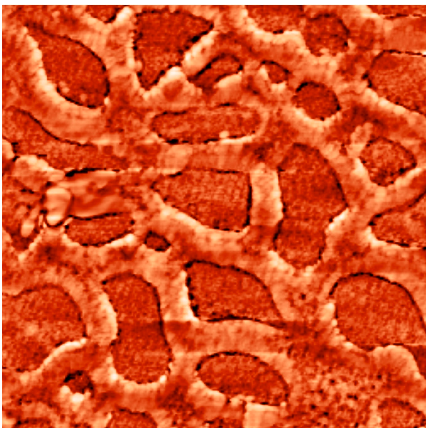
Figure 17. Atomic-force microscopy image (image size 2 μ m × 2 μ m) of porous structure based on tin dioxide and silicon dioxide with two types of pore sizes 200 nm and 400 nm. tin dioxide and silicon dioxide with two types of pore sizes 200 nm and 400